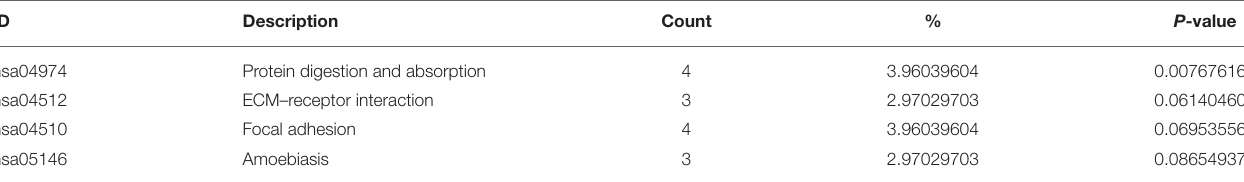
TABLE 5 | Kyoto Encyclopedia of Genes and Genomes (KEGG) pathways of genes in the royalblue module in the weighted gene correlation network